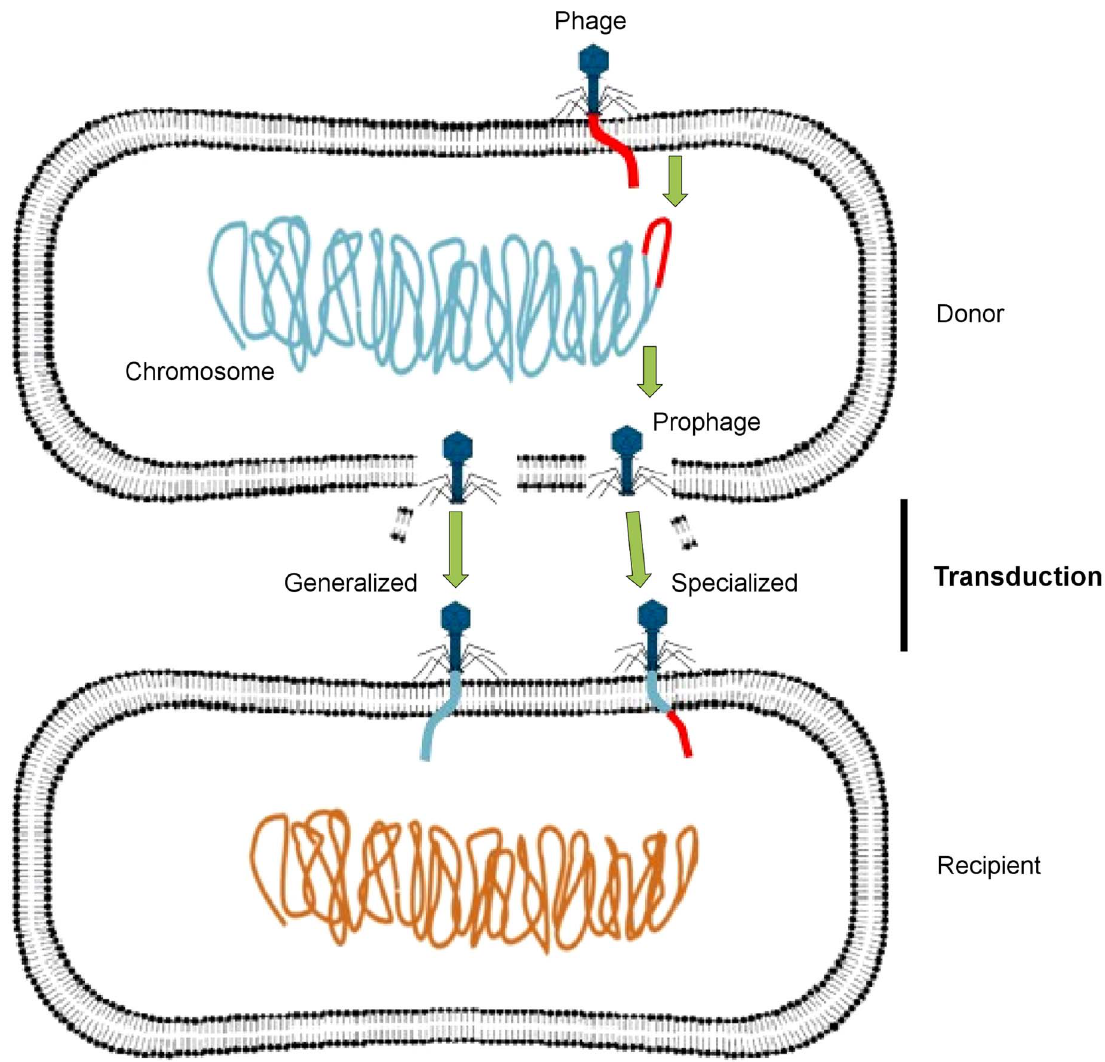
Figure 1. Transfer of DNA between bacteria via phages. A temperate phage inserts its genome (red) into the bacterial chromosome (blue- green) as a prophage, which replicates along with the bacterial chromosome, packaging host DNA alone (generalized transduction) or with its own DNA (specialized transduction). It then lyses the bacterial cell, releasing progeny phage particles into the surrounding environment. After lysis, these phages infect new bacterial cells, in which the acquired DNA recombines with the recipient cell chromosome (orange). This figure has been adapted from Frost et al. [2].